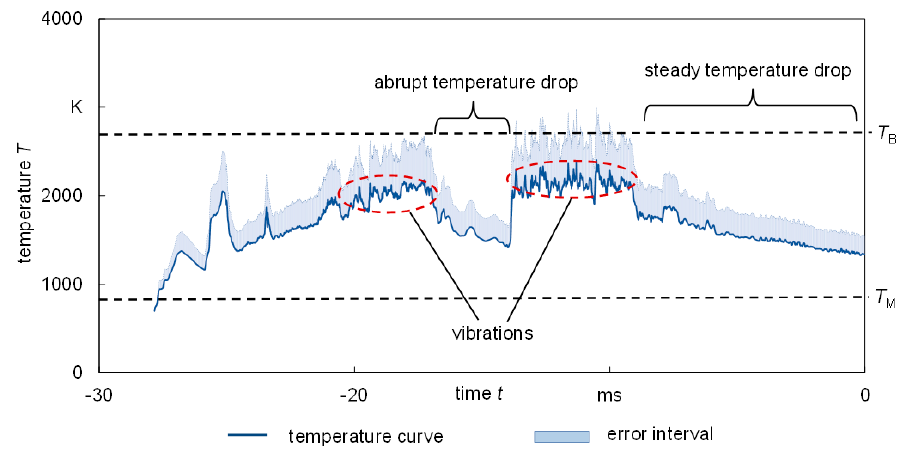
Figure 12. Temperature course from the prerunning melt to the probe destruction, i.e., within the keyhole prerunning